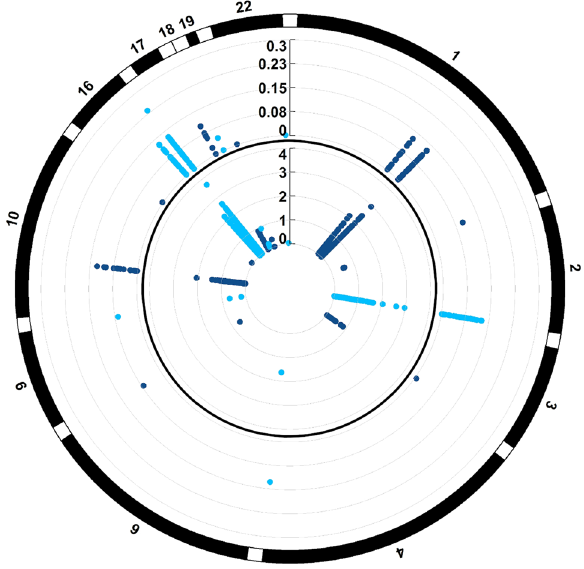
Figure 2. Methylation differences associated with episodic memory performance in the Finnish twins. The manhattan plots show multiple test corrected log10(p)-values in the outer circle and unadjusted log10(p)-values in the inner circle for CpG sites that were included in the analysis. Generalised linear mixed effects model (PQLseq) was utilised to test for plasma cfDNA methylation marks associated with EM performance within the seven twin pair sample